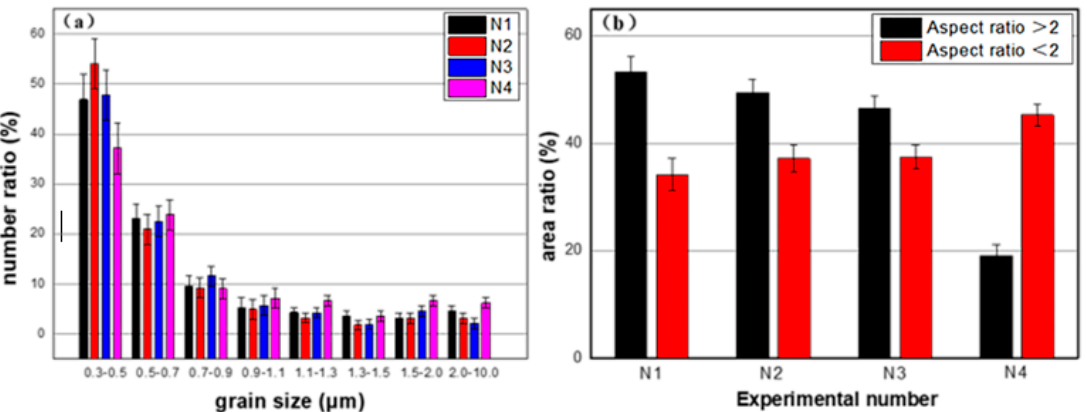
Figure 6. ( a ) Distribution of grain size of four coatings and ( b ) Area ratio of grains with different aspect ratio.